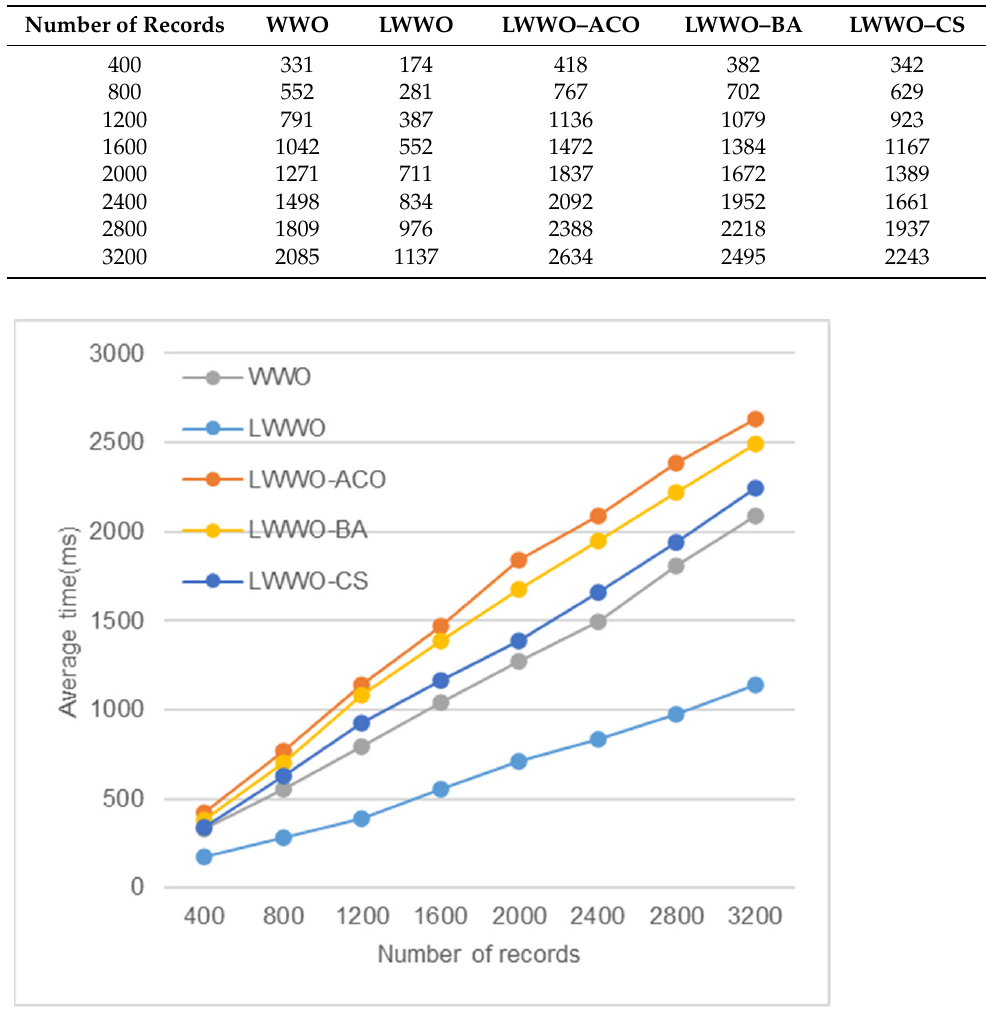
Figure 4. Time consumption of each algorithm with different data volume.